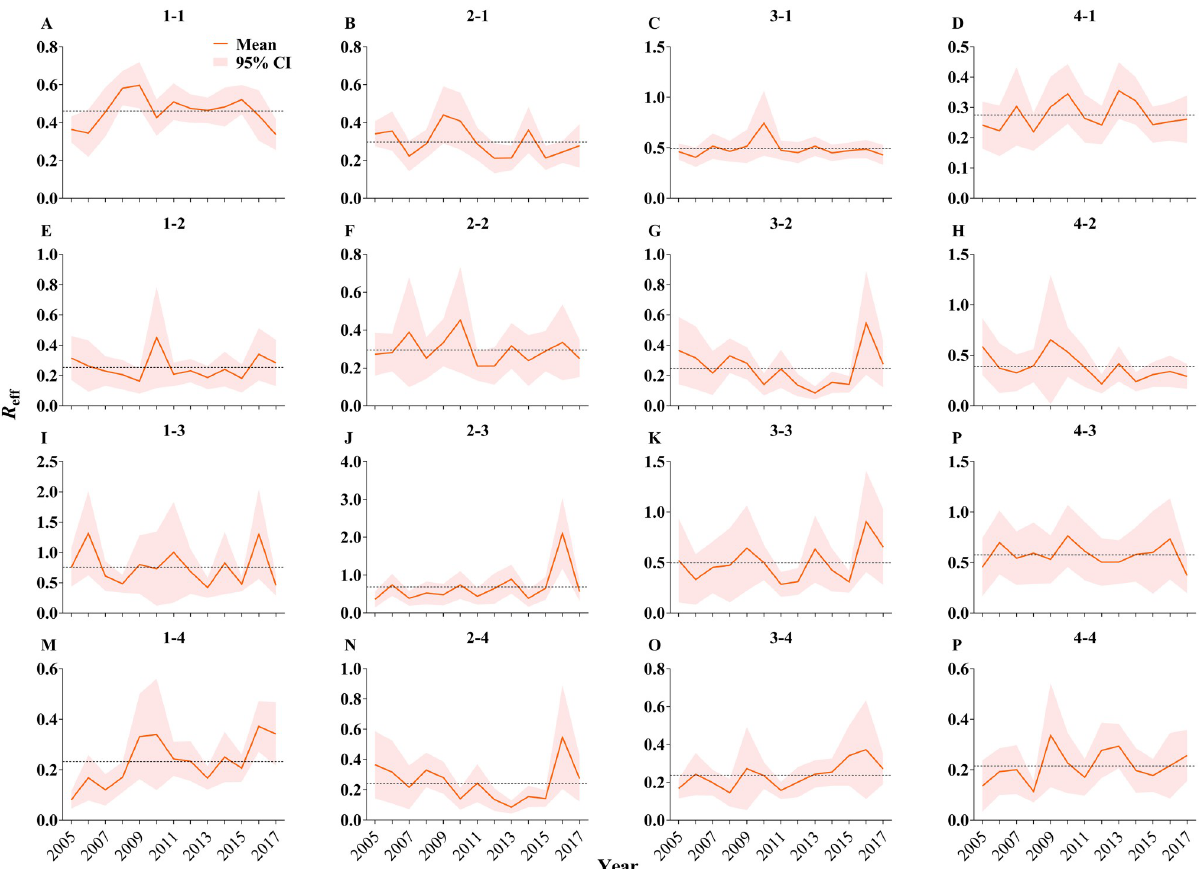
Fig 6. The R eff trend of each transmission route from 2005 to 2017. The 1 to 4 in each subgraph represent age group � 5 years old, 6–24 years old, 25–59 years old, and � 60 years old, respectively. The black dot line indicates the mean value of R eff . –means transmission route, such as 1–4 means transmission from � 5 years old to � 60 years